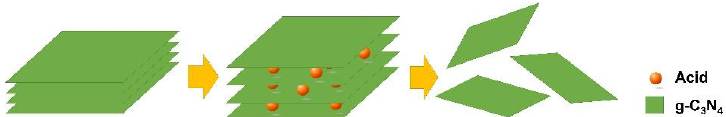
Figure 1. Schematic of the acid treatment enhanced liquid-phase exfoliation process from bulk g-C 3 N 4 to ultrathin nanosheets.